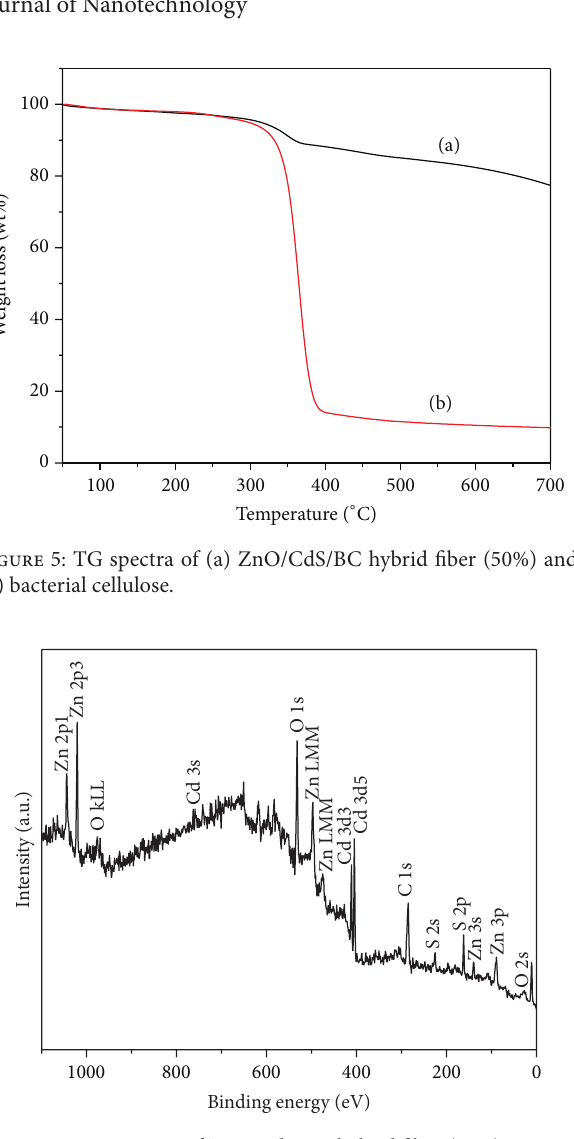
source such as bacterial cellulose. Cadmium, zinc, sulfur, and oxygen are expected from the chemical composition of CdS and